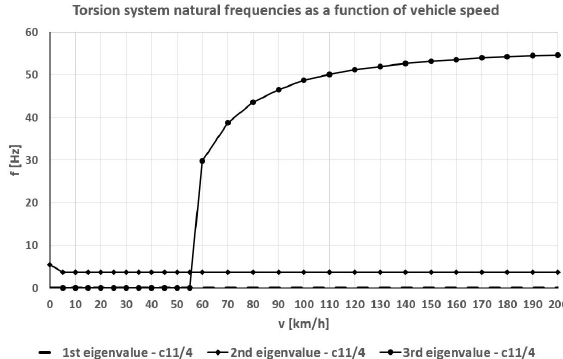
Figure 22. Natural frequencies as a function of ve- locity – c 11 /